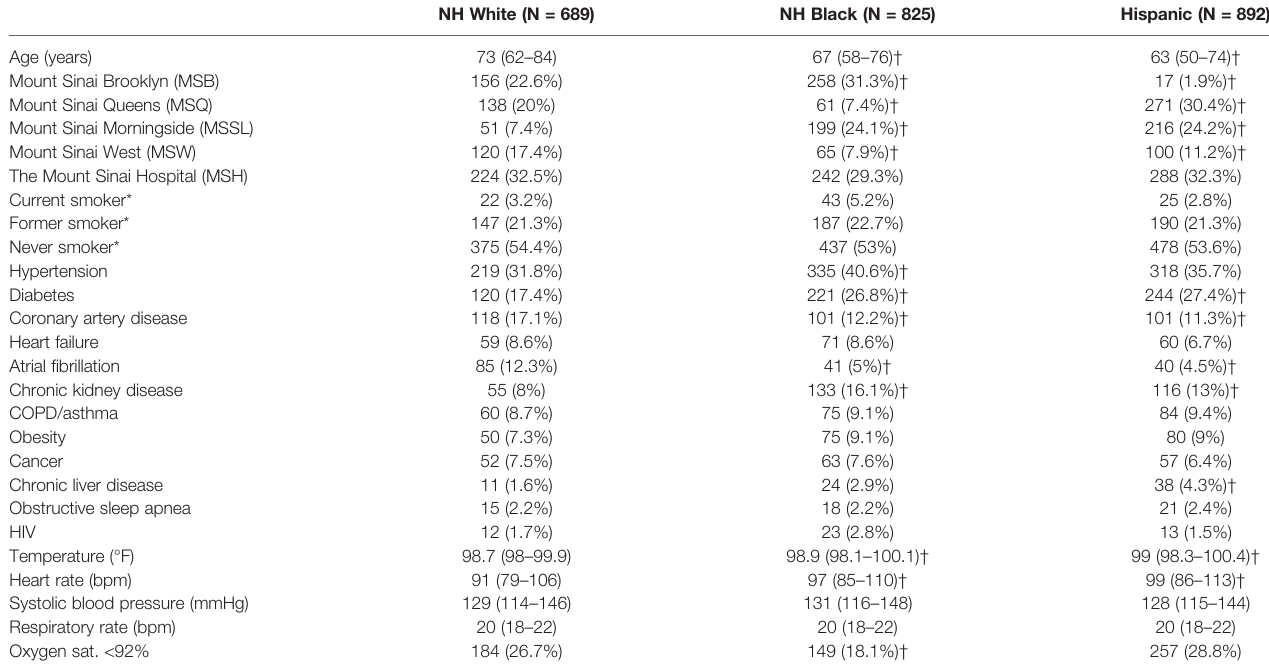
TABLE 1 | Baseline demographic and clinical characteristics, by race/ethnicity.